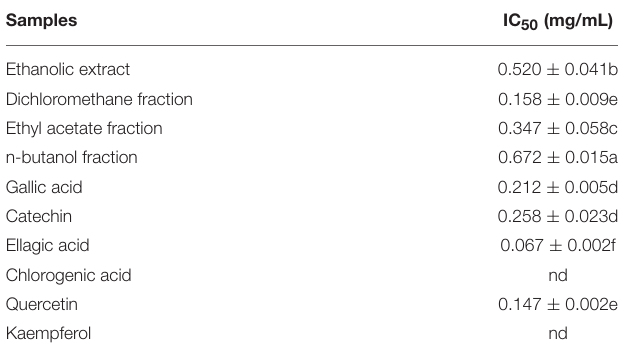
TABLE 3 | Half maximal inhibitory concentrations (IC 50 ) of four fractions and six compounds identified from Camellia nitidissima Chi flowers on pyocyanin production of Pseudomonas aeruginosa PAO1.